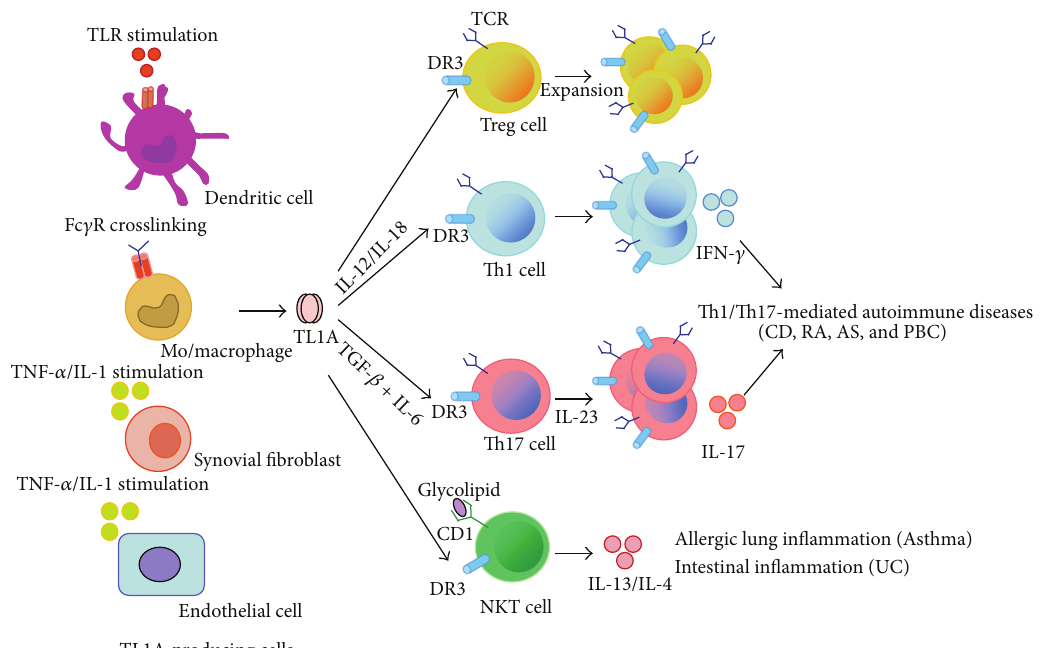
Figure 1: TL1A connects innate immune responses to adaptive immune responses and is critically involved in the induction of autoimmune and inflammatory